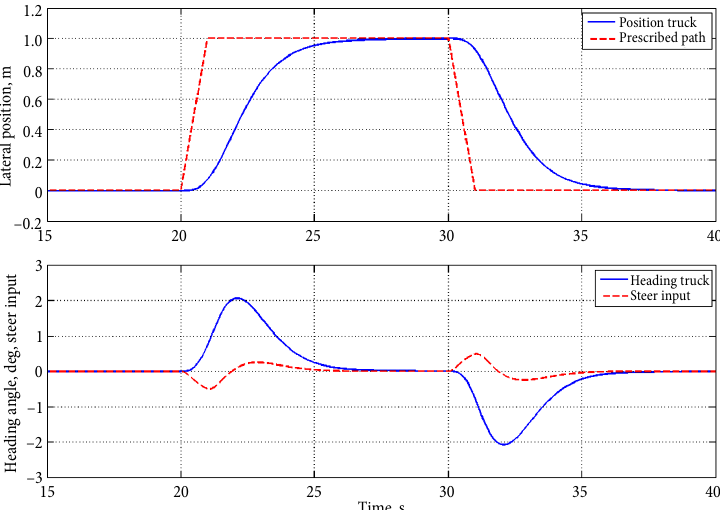
Fig. 11. Simulation of the closed loop double lane change